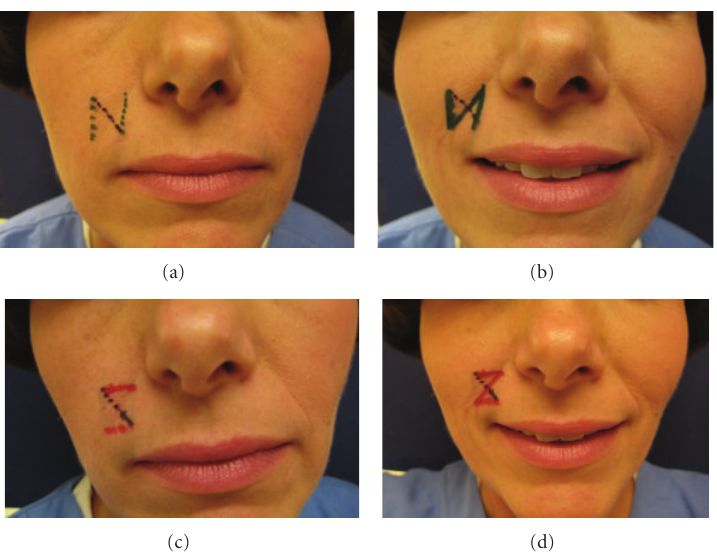
Figure 4: For a scar that crosses the melolabial fold (black line) in an undesirable perpendicular fashion, there are two ways that the Z-plasty could be performed to change the scar direction (represented by the green and red inks in Figures 4(a) and 4(c)). Although both options will change the scar direction to match the melolabial fold, only one of the designs (green ink Figure 4(b)) allows for the limbs of the Z- plasty to align with the RSTLs of the cheek and lip. Conversely, in Figure 4(d) even though the mirror image also realigns the central limb appropriately, the resultant lateral limbs cross the RSTL of the lip and cheek in an undesirable perpendicular